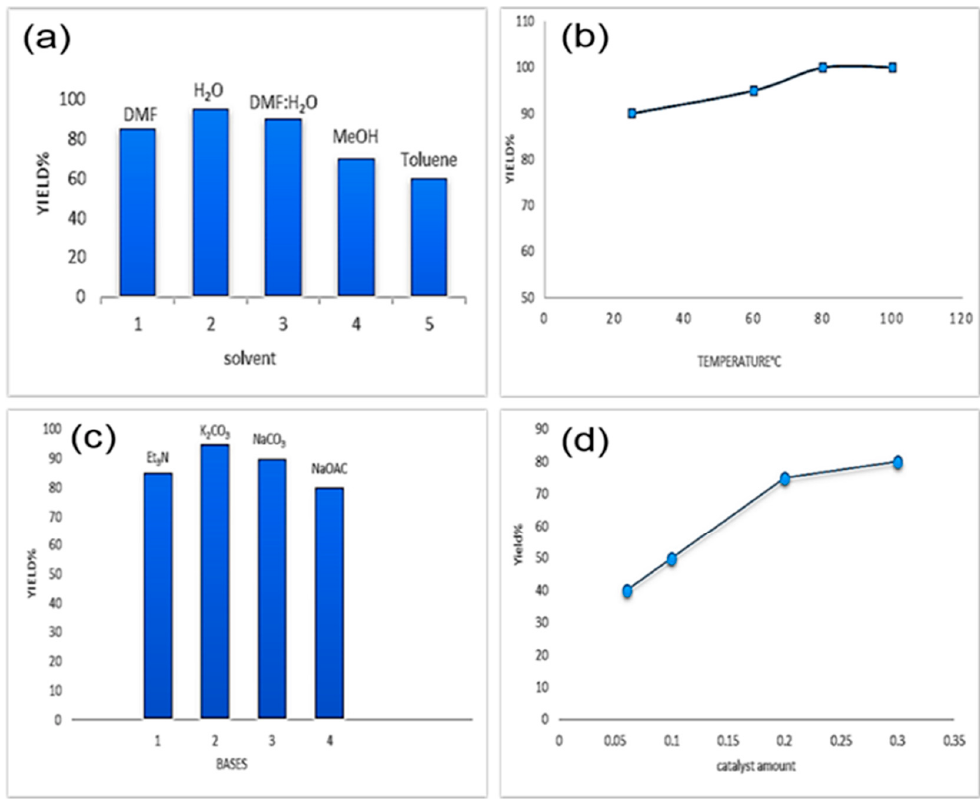
Figure 4. Cross-coupling of 4–bromoacetophenone and phenylboronic acid substrate as a model